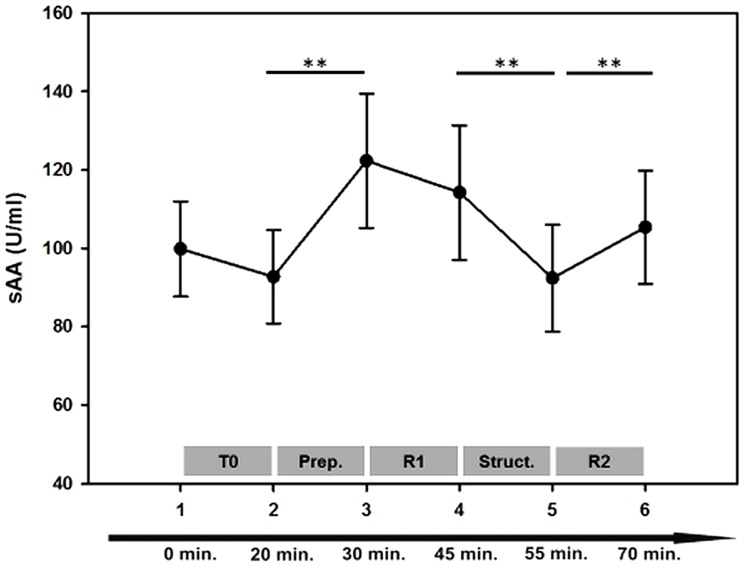
Salivary alpha-amylase (sAA) profile over the six sampling points.Error bars indicate SEM. T0  =  training phase; Prep.  =  MRI preparation (subjects were placed on the MRI table, get goggles, headphones, headcoil, ect.); R1  =  Run 1; Struct.  =  high resolution structural scan; R2  =  Run 2. **p<0.01.